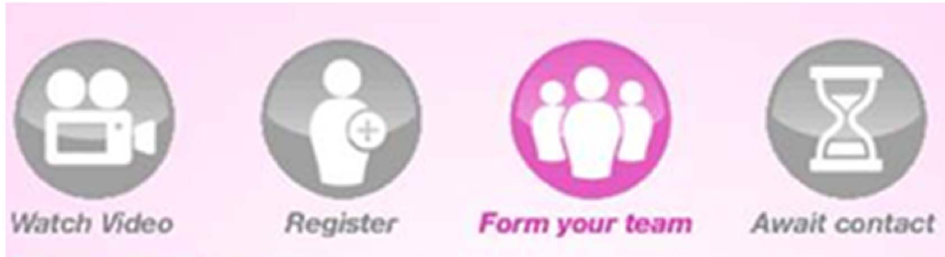
Figure 4. Step-by-step graphic added to the app to aid with participant registration.